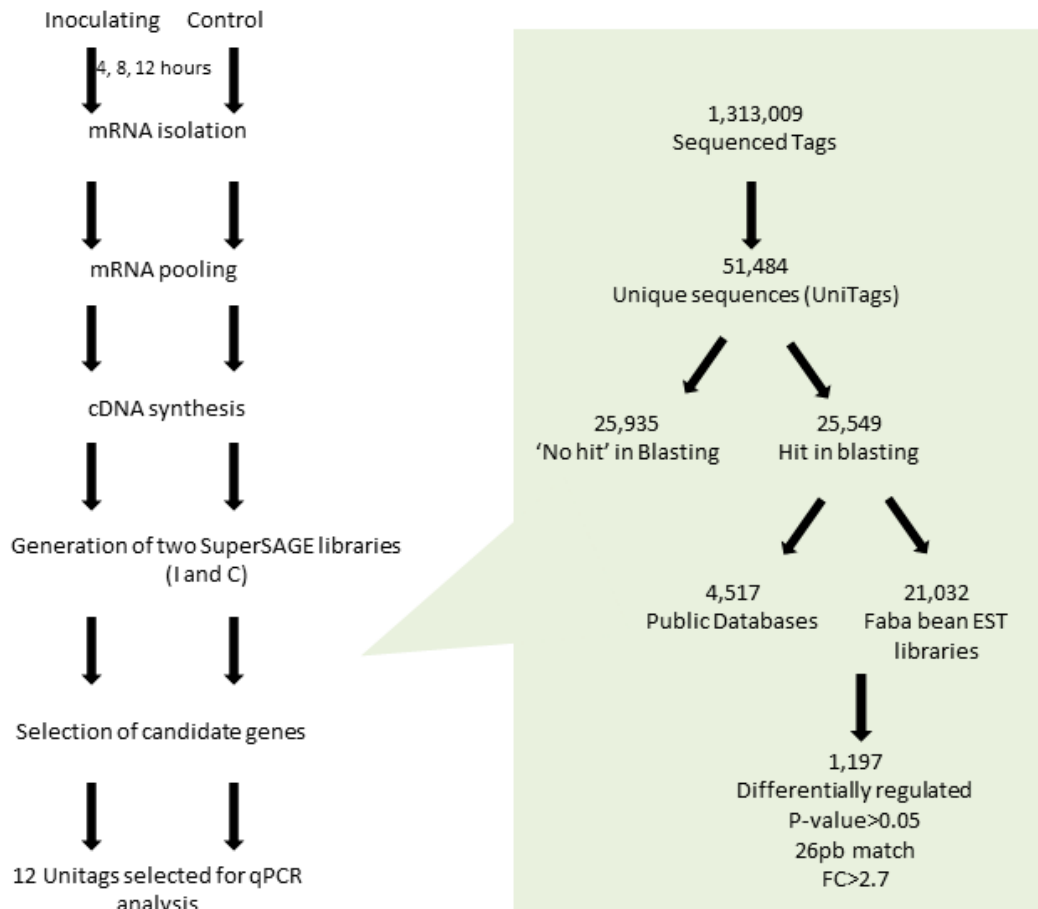
Figure 1. Schematic representation of the approach used for identification of regulatory genes by SuperSAGE. Two Su - perSAGE libraries were generated from faba bean leaves of the resistant genotype Vf29H. Plants were harvested 24 hours after Ascochyta fabae inoculation. Replicated plants in the same conditions were included in the assay, to be used as control. From these libraries, 1,197 unique mRNAsequences (UniTags) were defined as differentially expressed (FC,